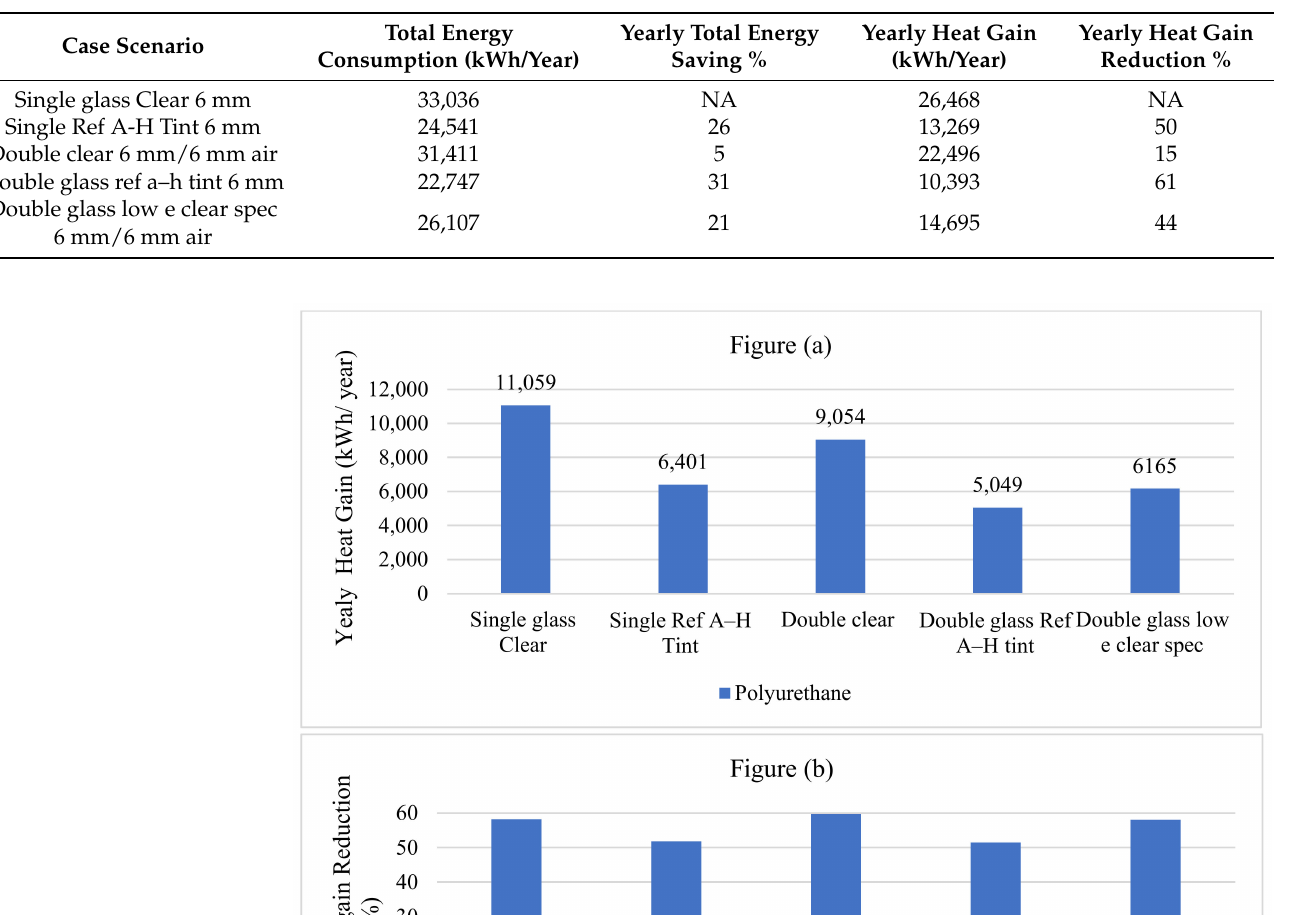
Table 5. Estidama standards and the software achievements of base case.